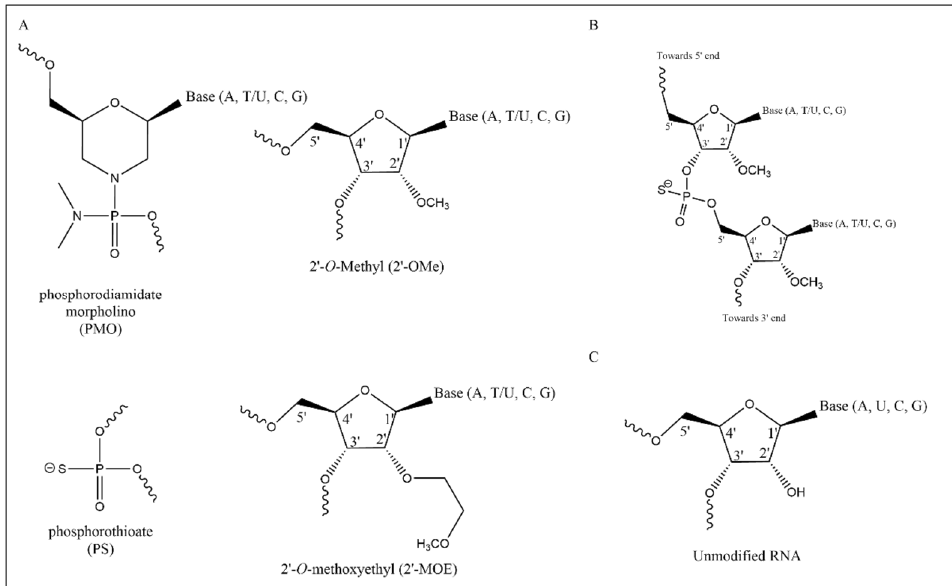
Figure 1. ASO chemistries ( A ) Different chemical modifications of the nucleotide ribose-ring (‘chem- istry’) used in EB exon skipping ASOs. Curved lines indicate the place of linkage to other nucleotides. ( B ) Schematic representation of two 2 ′ -OMe-PS modified RNA-nucleotides. ( C ) An unmodified RNA structure.